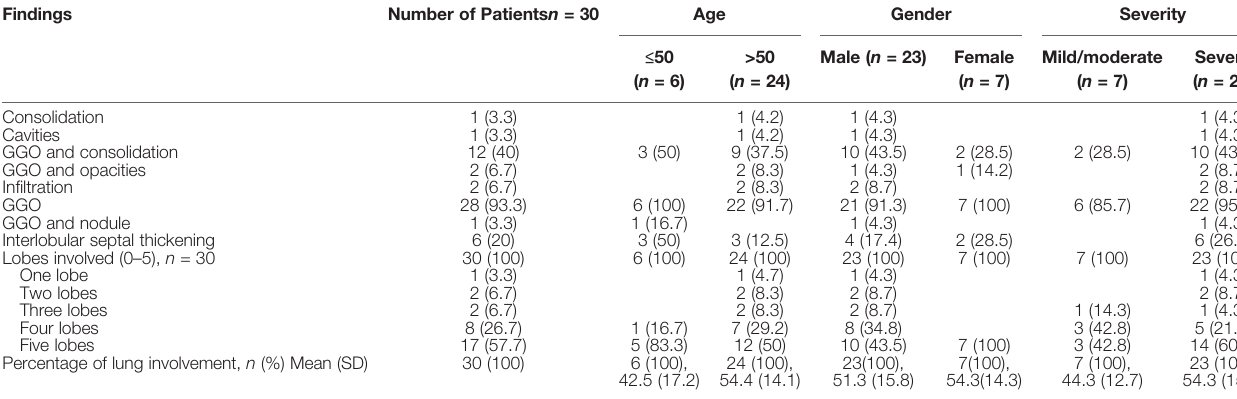
TABLE 7 | Findings of the CT scan of 30 COVID-19 patients.